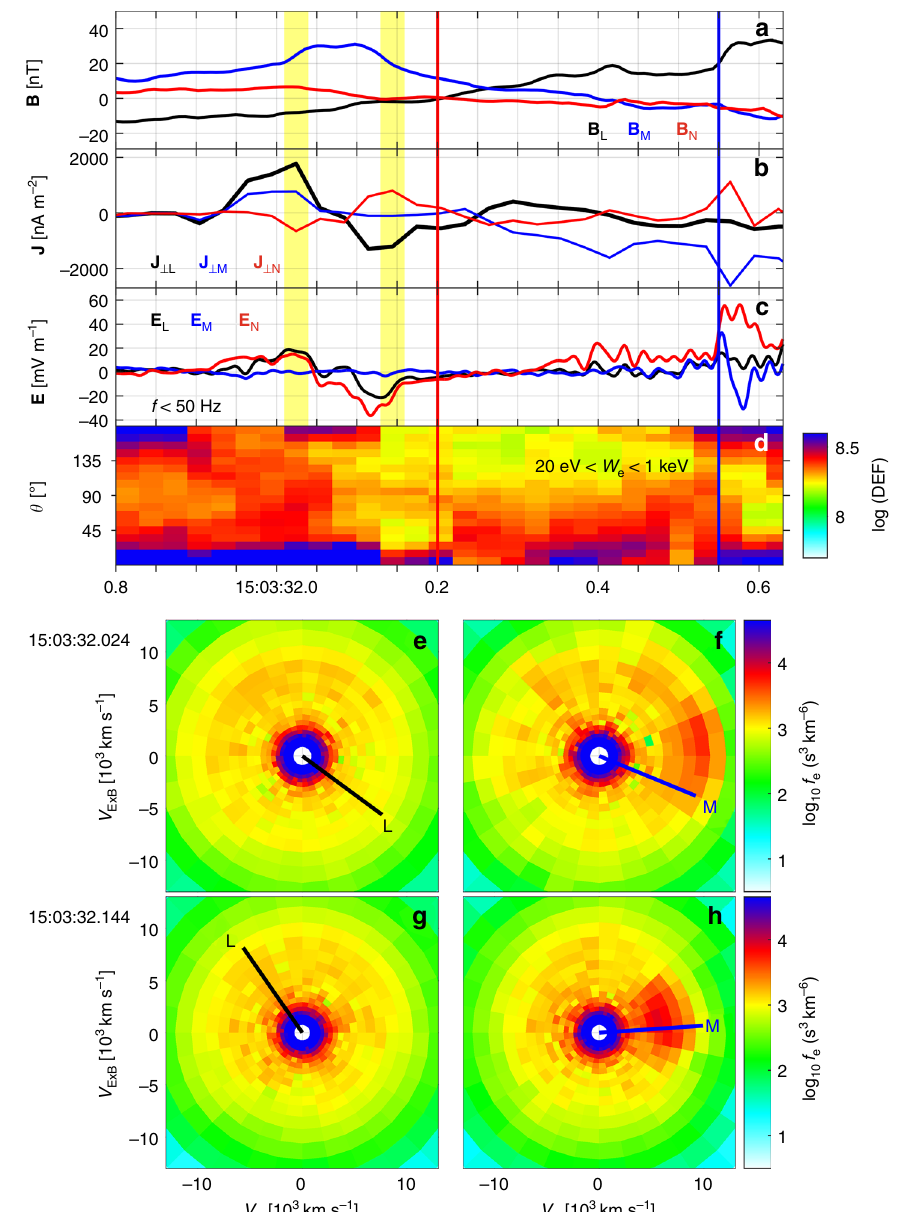
Fig. 3 Electron-scale boundary of the Hall current reversal. a B . b Perpendicular components of J calculated by high-resolution FPI particle moments. c E with f < 50 Hz. d Electron pitch-angle distribution between 20 eV and 1 keV. The red and blue vertical lines represent the neutral line and the magnetospheric separatrix, respectively. e – h Electron distributions at times indicated by the two vertical yellow bars in ( a – c ), respectively. J calculated by FPI data agrees well with the current estimated by the curlometer method 40 , which has been veri fi ed by the current event and other MMS events 37,38 . The vectors are all presented in LMN coordinate system, and the L and M directions normalized by 10 4 km s (cid:1) 1 are projected on ( e – h